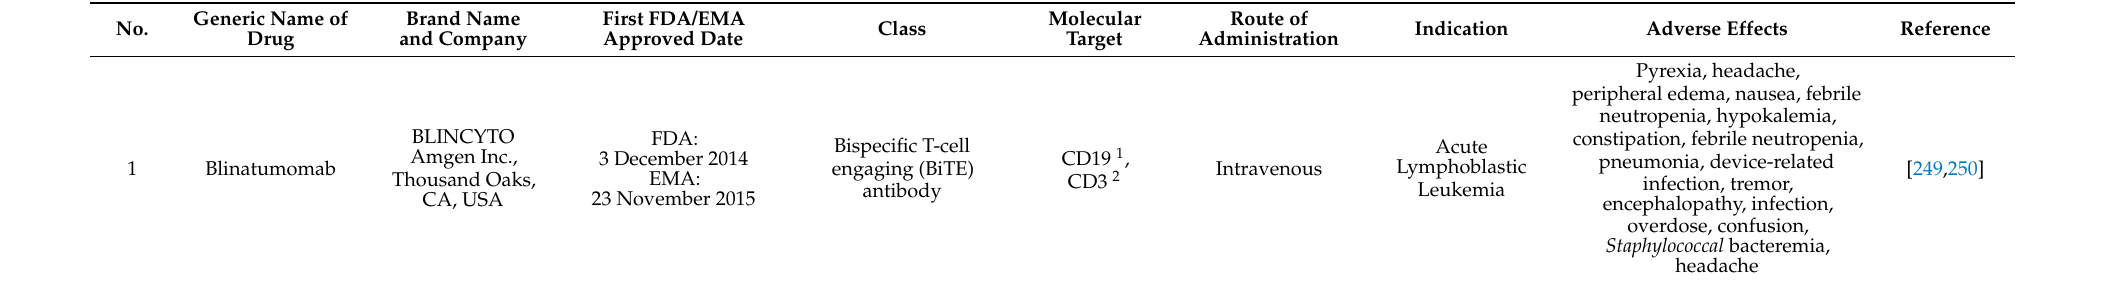
Table 12. Features of the bispecific monoclonal antibody drug approved by the Food and Drug Administration (FDA) from 2011 to 2021.